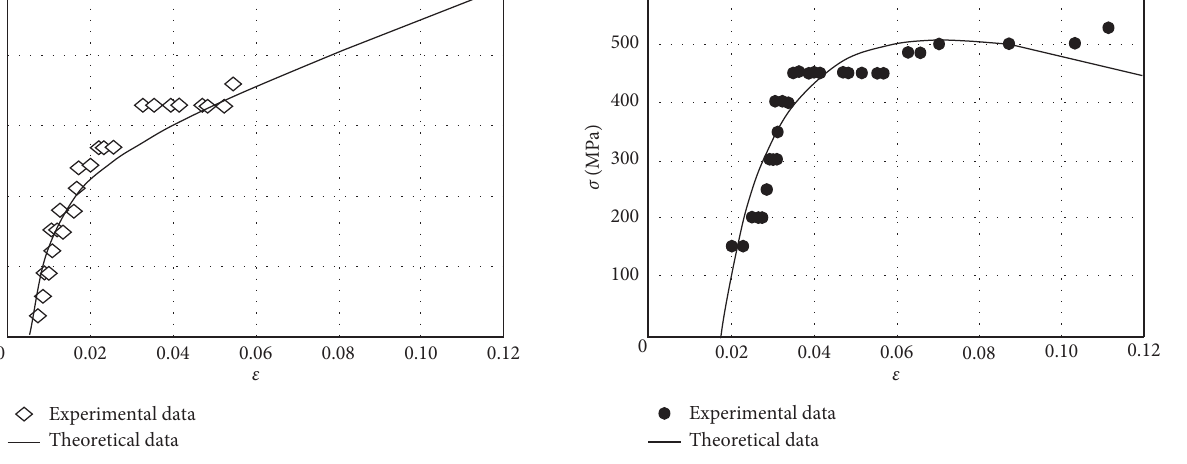
Figure 13: The dependence between the average value of micro- plastic deformation and the applied tensile stress in the deposited samples of steel S 40 after normalization (group